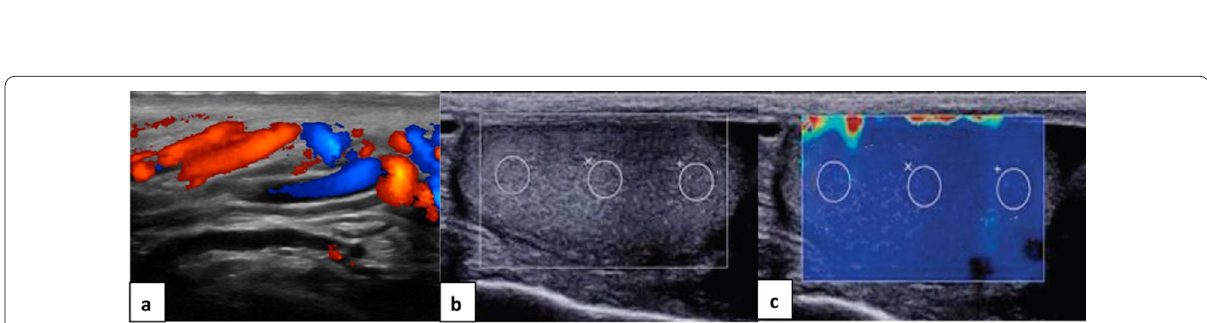
Table 1 Mean testicular stiffness (elasticity) among patients with testicular varicocele and healthy